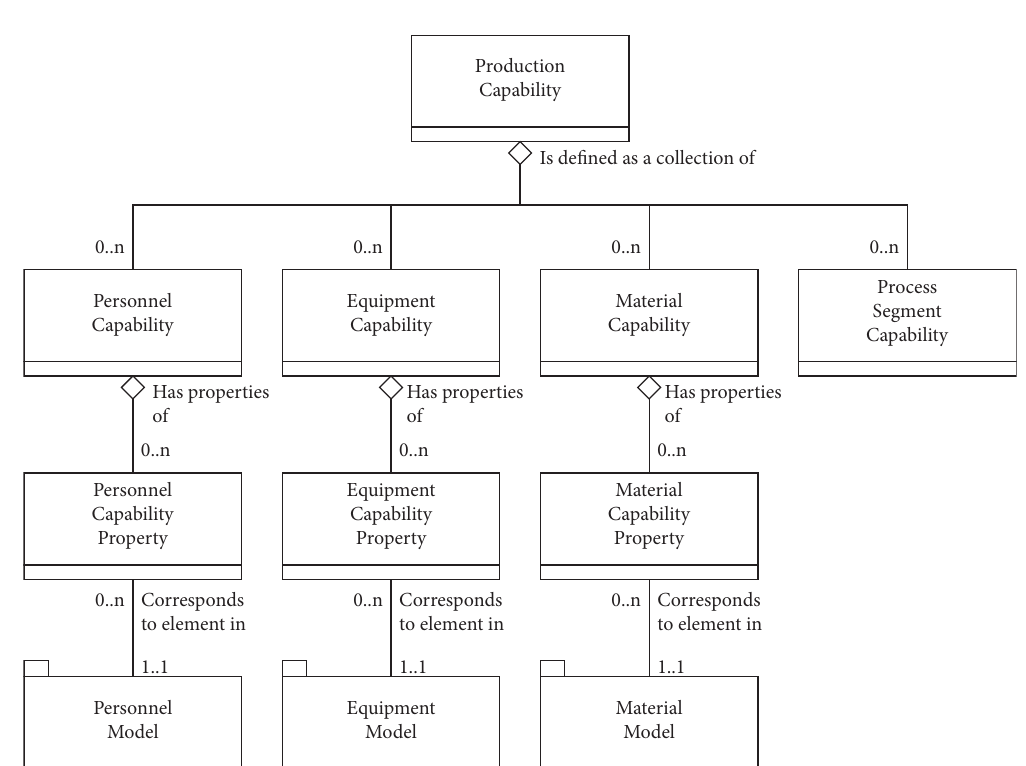
Figure 5: The Production Capability model (IEC 62264) in the figure. The Semantic Web Stack of the W3C (World Wide Web Consortium) is a significant building block of the RAMI 4.0 system (see Figure 9).